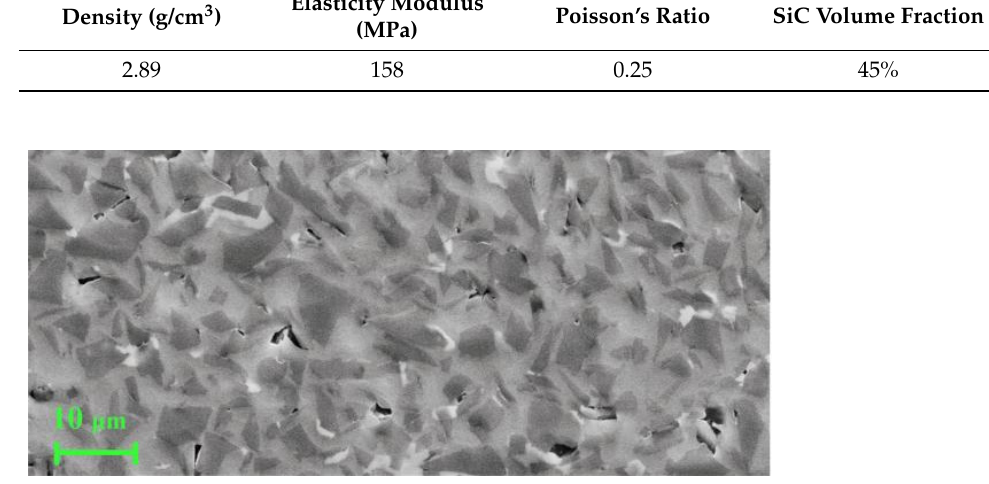
Figure 5. SEM image of SiCp/Al composite.